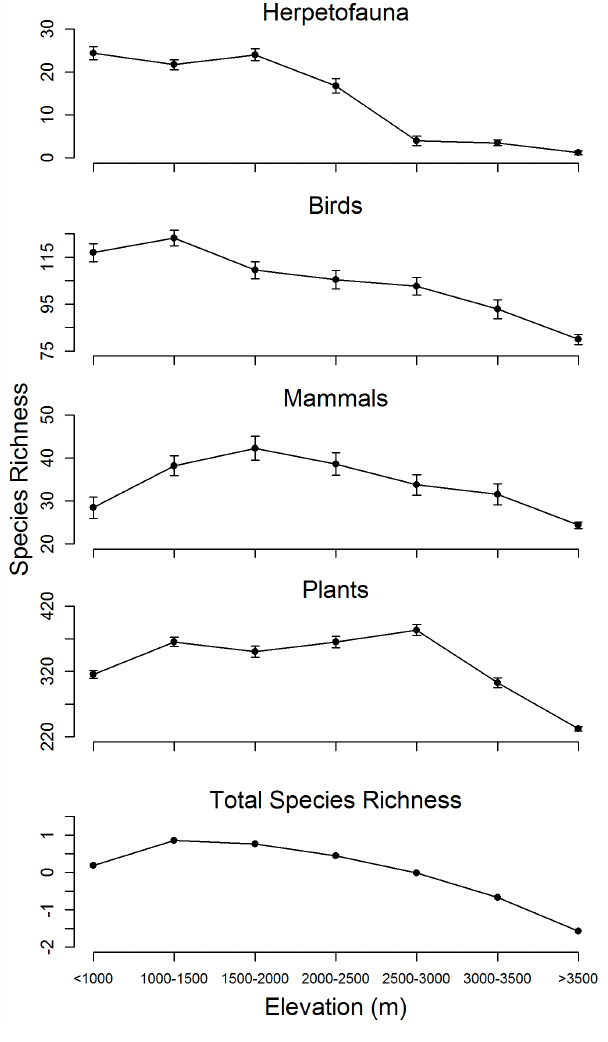
Figure 4. Estimated species richness values by elevation zone. Species richness values estimated using rarefaction for amphibians and reptiles (herpetofauna), mammals, birds, plants, and total species